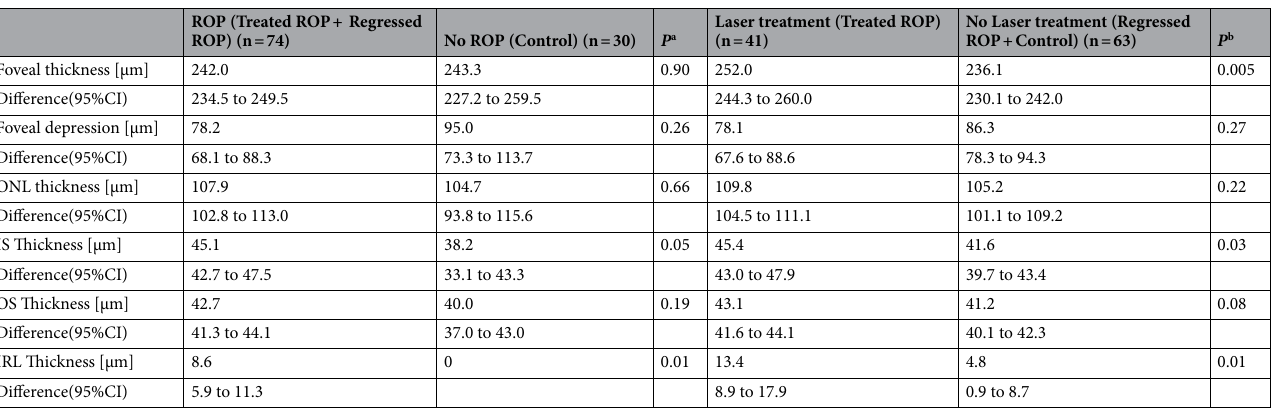
Table 3. Effect of the retinal layer thickness to the retinopathy of prematurity and the laser treatment. Data are expressed as adjusted mean based on analysis of covariance (ANCOVA). P value a ANCOVA adjusted for gestational age and laser treatment b ANCOVA adjusted for gestational age and ROP. ROP: retinopathy of prematurity, CI, confidence interval, ONL: outer nuclear layer, IS: inner segment, OS: outer segment, IRL: inner retinal layer.